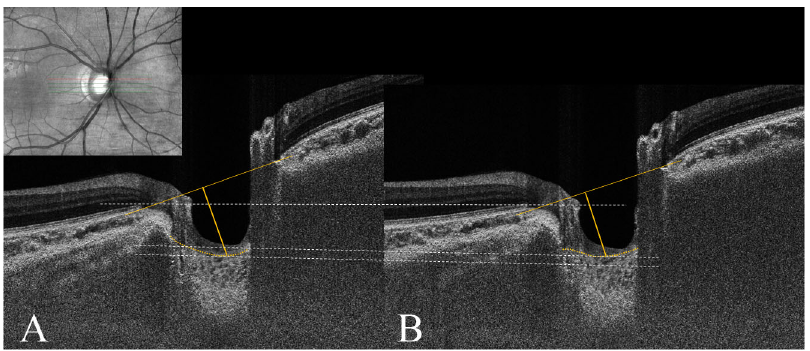
Fig 1. Anterior displacement of lamina cribrosa (LC) during standardized Valsalva maneuver. Enhanced depth imaging (EDI) optic disc scan of 26-year-old healthy male (A) at baseline and (B) during standardized Valsalva maneuver. Note that adaptive compensation was performed to enhance lamina cribrosa (LC) visibility. The anterior LC depth (LCD) was defined as the maximal distance between the reference plane connecting the Bruch ’ s membrane openings (BMO) and the anterior LC surface. The LCD decreased from 607 μ m at baseline to 563 μ m during the Valsalva maneuver, while the intraocular pressure (IOP) increased from 14 mmHg at baseline to 17